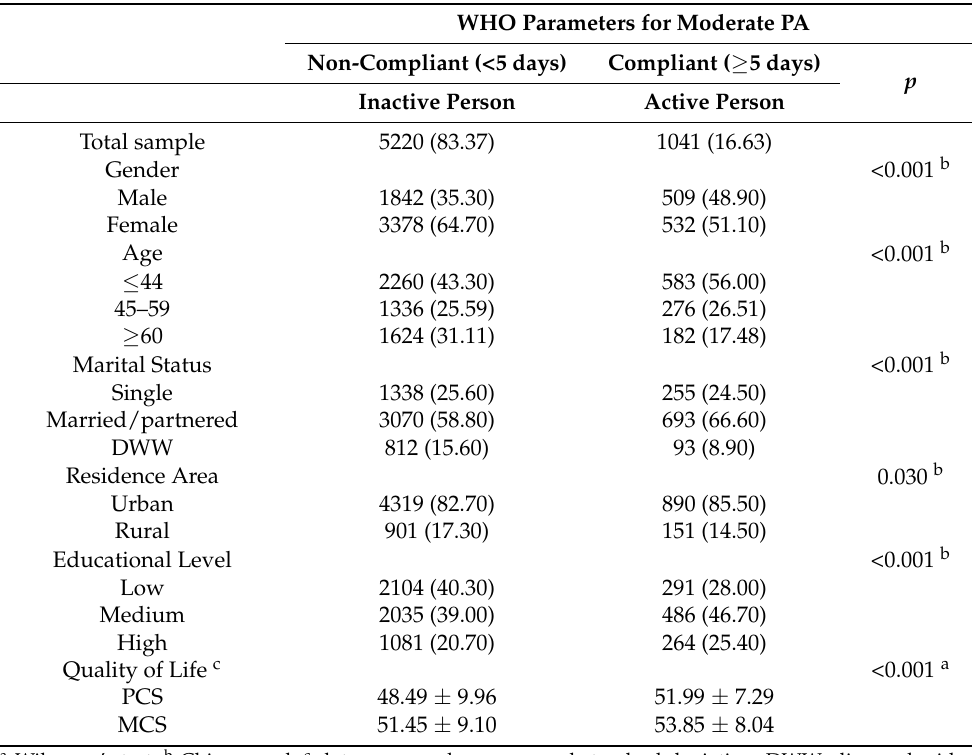
Table 3. Comparison of compliance with the WHO-designated parameters for moderate PA (days) according to sociodemographic